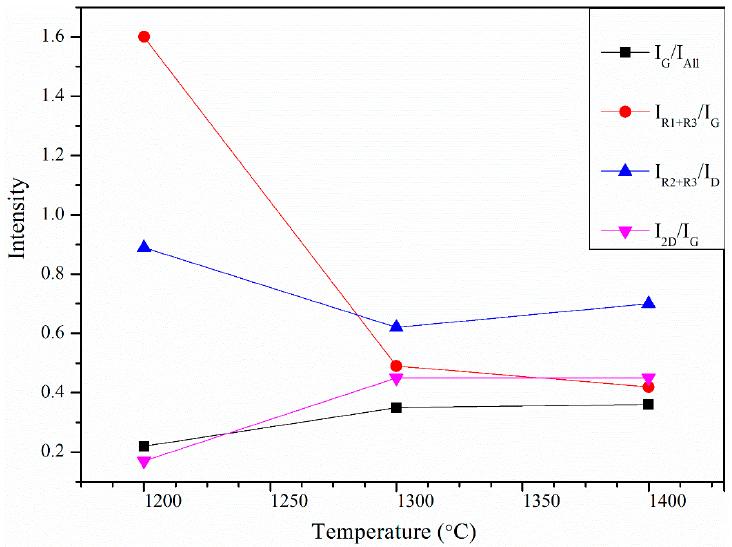
Figure 8. Band area ratio variations from the curve-fitting analysis of SL-CNTs Raman spectra as a function of temperature.